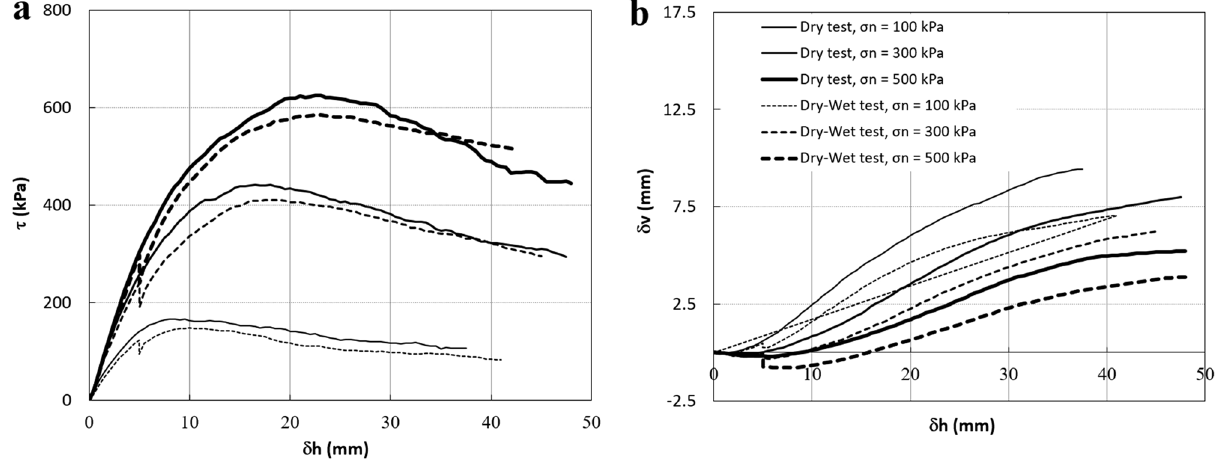
Figure 7. Direct shear test results on specimens with sub-angular particle shapes (Dr = 85%). ( a ) Shear stress– shear displacement. ( b ) Vertical displacement-shear